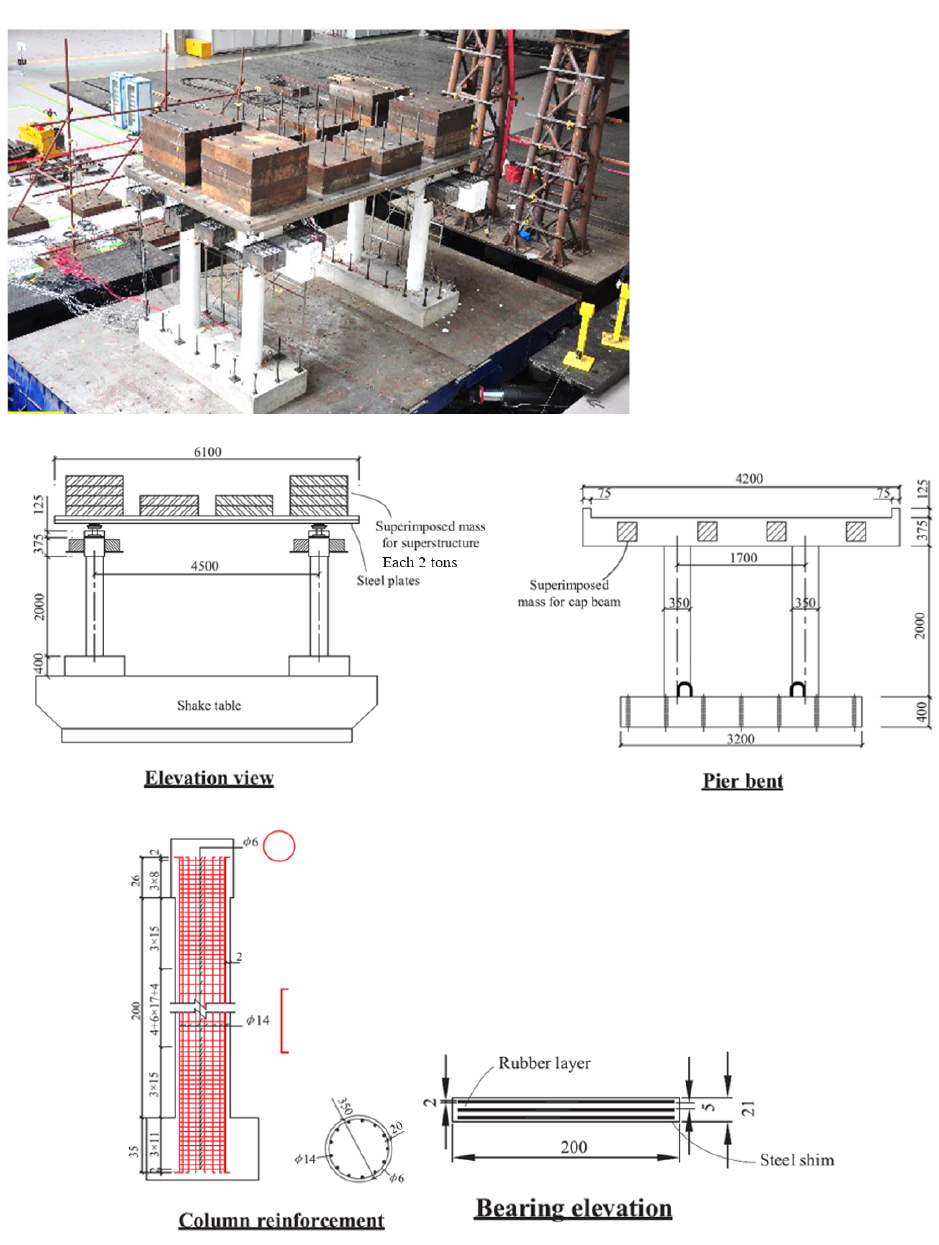
Figure 7. Details of the bridge model [unit: mm]. Reprinted with permission from ref. [43]. Copyright Elsevier.